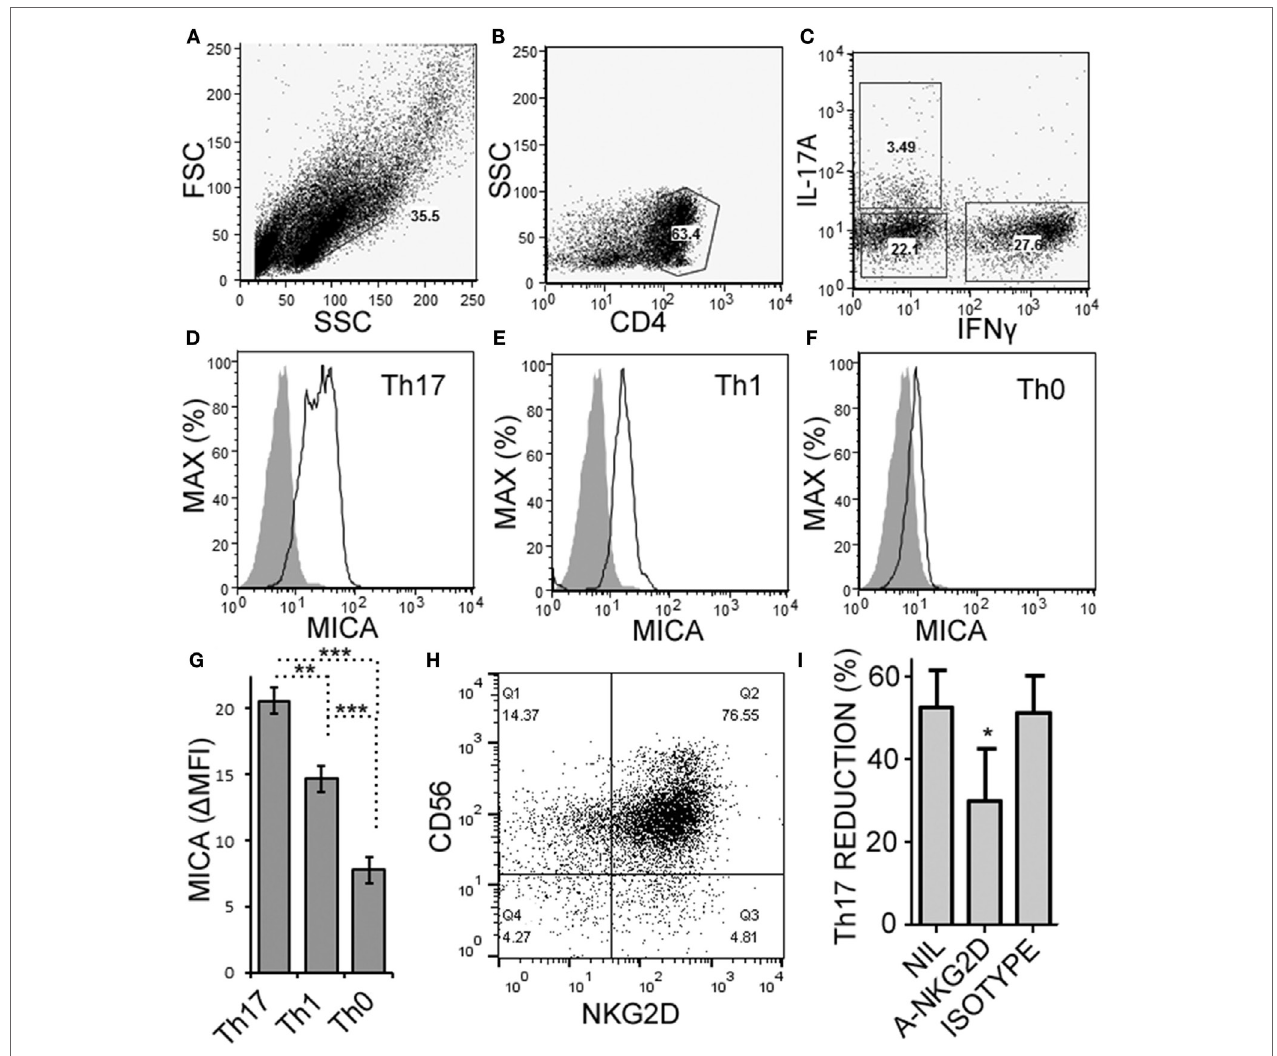
FigUre 6 | Activated memory CD4 + T cells express MICA and are sensitive to NKG2D-mediated natural killer (NK) cell cytotoxicity. Memory CD4 + T cells were obtained from healthy subject PBMC, as described in Figure 5 , and activated with anti-CD3, anti-CD28, and Th17 polarizing factors for 4 days. Expression of CD4, MICA (Zenon labeled), IL-17A, and IFN- γ were assessed by intracellular cytokine staining and flow cytometry. Representative plots of FSC × SSC (a) , CD4 × SSC (B) , and IL-17A × IFN- γ (c) are shown. MICA expression on Th17 (D) , Th1 (e) , and the Th0 cells (F) is shown. Open histogram indicate MICA stained cells and closed histograms indicate an isotype control. The average mean fluorescent intensity of MICA minus the isotype control is shown [ Δ MFI; (g) ]. Expression of CD56 and NKG2D by NK cells was assessed by flow cytometry and a representative plot is shown (h) . NK cells were cultured with memory CD4 + T cells and activated with anti-CD3, anti-CD28, and Th17 polarizing factors, at the same time treated without antibody, (NIL), anti-NKG2D neutralizing antibody, or isotype control antibody (i) . N = 7